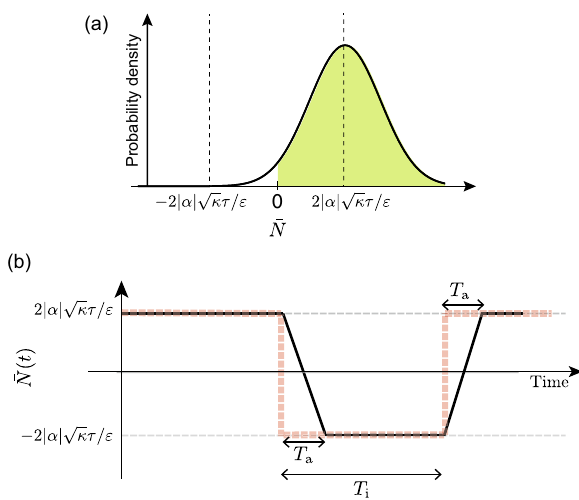
α |√ κτ/ε . The 2 = | 0 (without time averaging) and 0 < T a < T i =